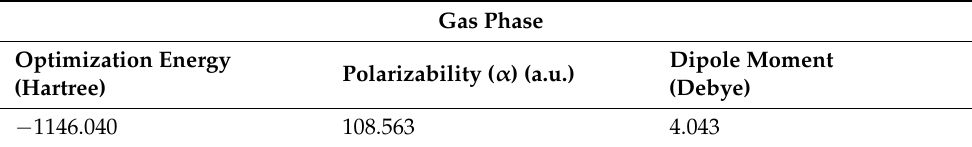
Table 4. Geometric parameters of the selected compound 4